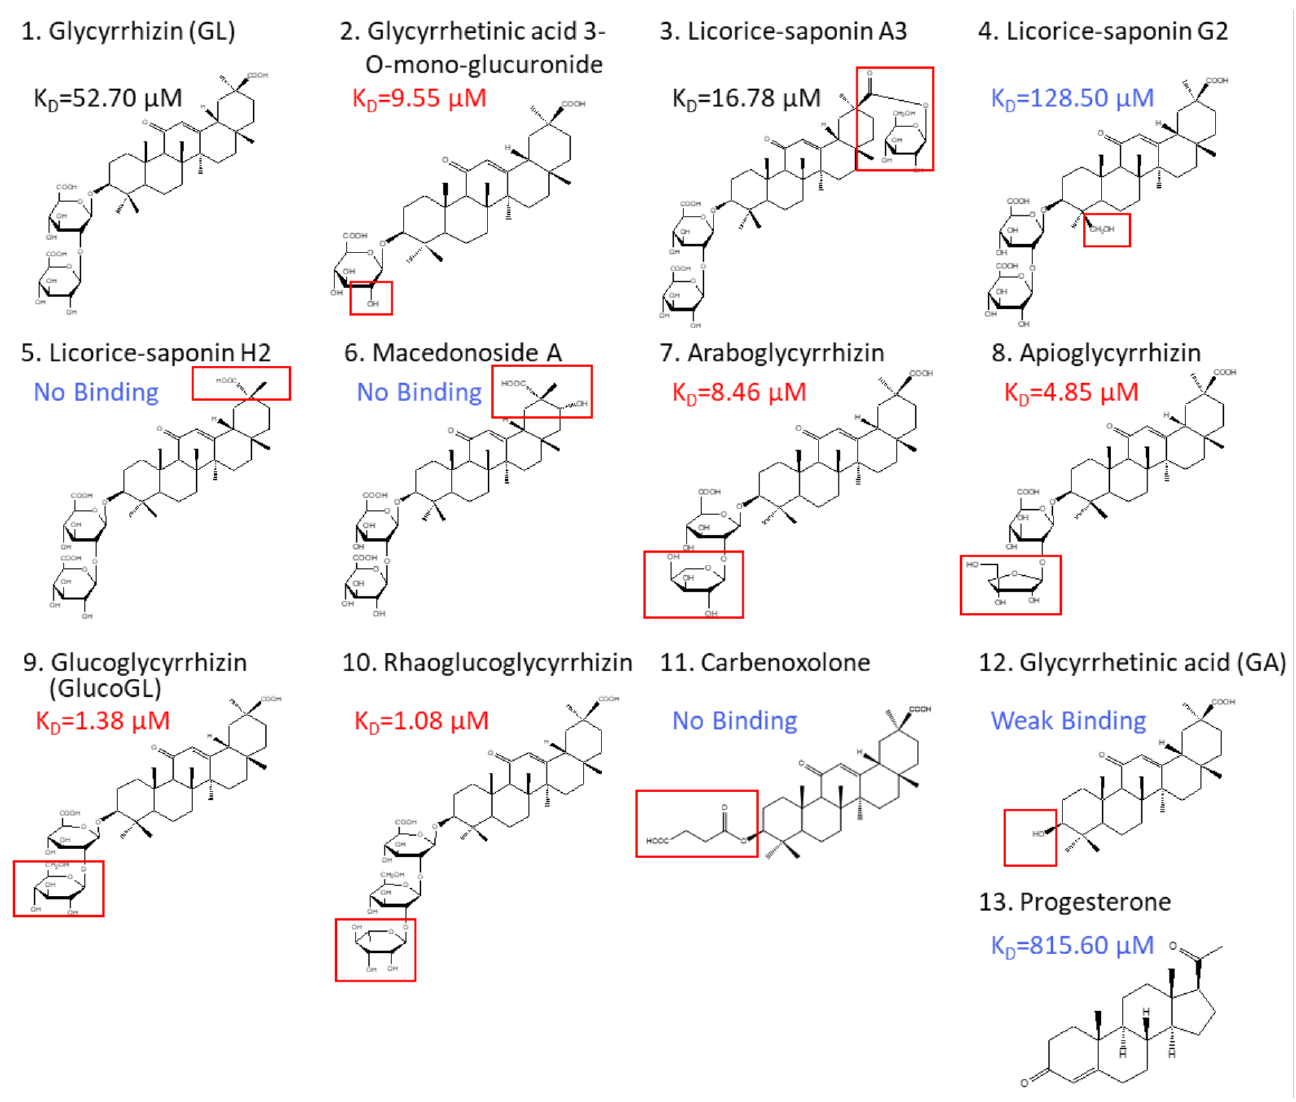
Figure 3. Chemical structures of GL derivatives examined in this study. The red squares show the structural regions that differ from GL. Binding affinities (K D ) for PGRMC1 were analyzed using ITC. Table 1. Binding affinity of GL derivatives with